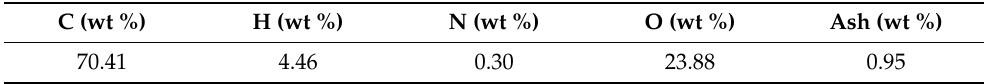
Table 4. Elemental analysis of